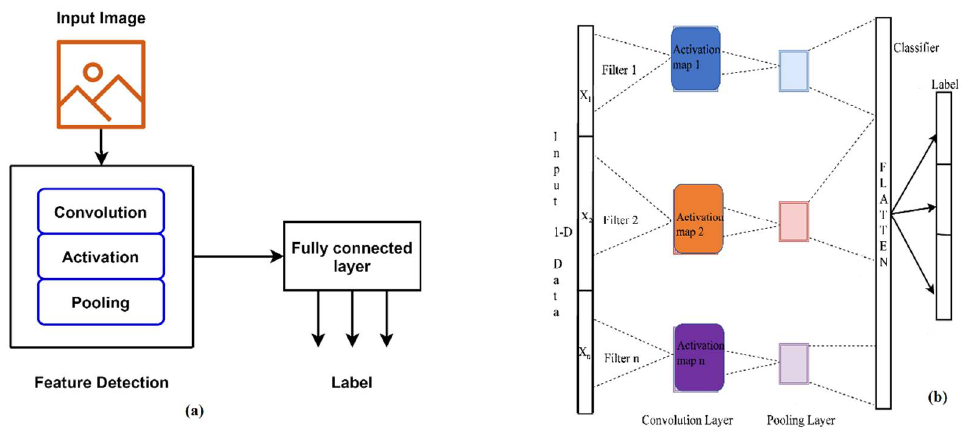
Figure 6. ( a ) Common 2-D CNN network architecture and ( b ) 1-D CNN architecture.